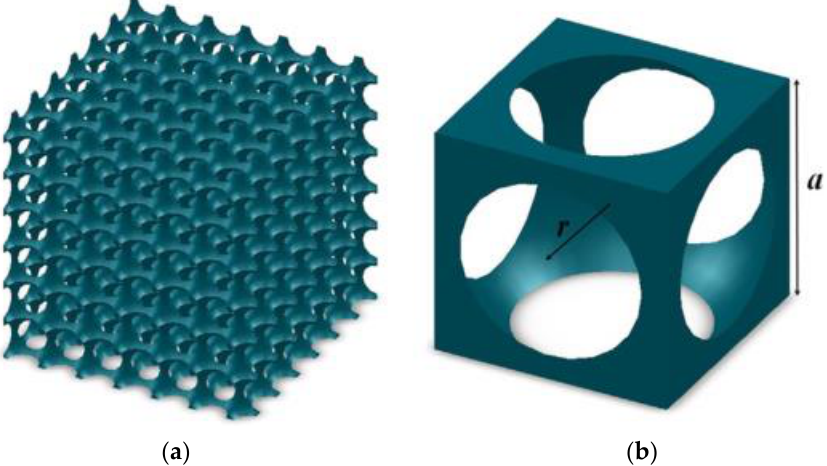
Figure 15. Spherical hollow cube model: ( a ) Overall view; ( b ) A spherical hollow cube.